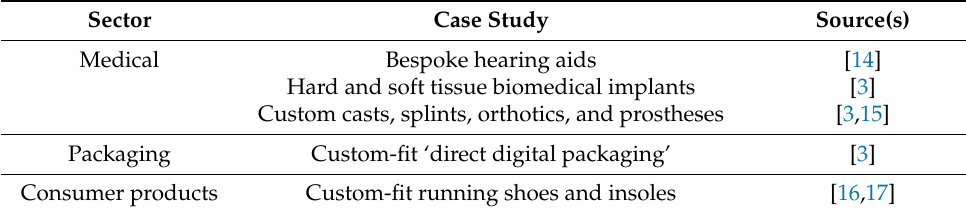
Table 2. Prominent case studies of mass customization across its three primary application